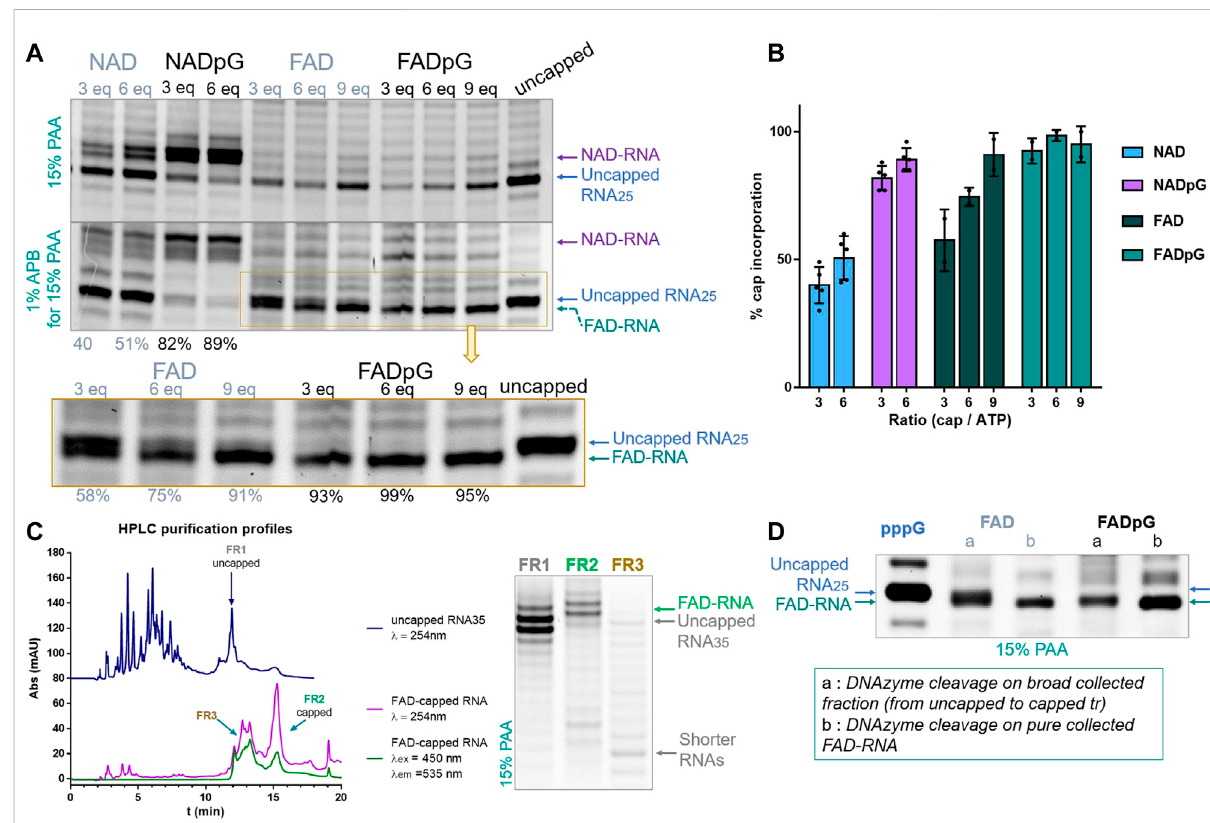
FIGURE 5 (A) Representative HRPAGE (15% PAA, 7 M urea, 1 # TBE, SYBR Gold), without APB (upper gel) or with 1% APB (bottom gel), of 25 nt IVT RNA obtained from a template with the φ 2.5 promotor after 3 ′ end trimming steps. The capping ef fi ciency values given below the gel indicate the mean values from triplicate analyses performed on three independent transcriptions and 6 densitometric measurements (+/- APB) for NAD and NADpG, and from duplicate analyses FAD and FADpG (only APB). (B) Comparison of capping ef fi ciencies under different conditions as a function of nucleotideanalog/GTPratio. (C) HPLCpuri fi cationpro fi lesofIVTuncappedandFAD-cappedRNAs,withcorrespondingHRPAGEanalysis(15%PAA, 7 M urea, 1 # TBE, SYBR Gold) of the collected fractions. (D) HRPAGE (15% PAA, 7 M urea, 1 # TBE, SYBR Gold) of RNAs after DNAzyme trimming on uncapped, FAD initiated and FADpG initiated IVT